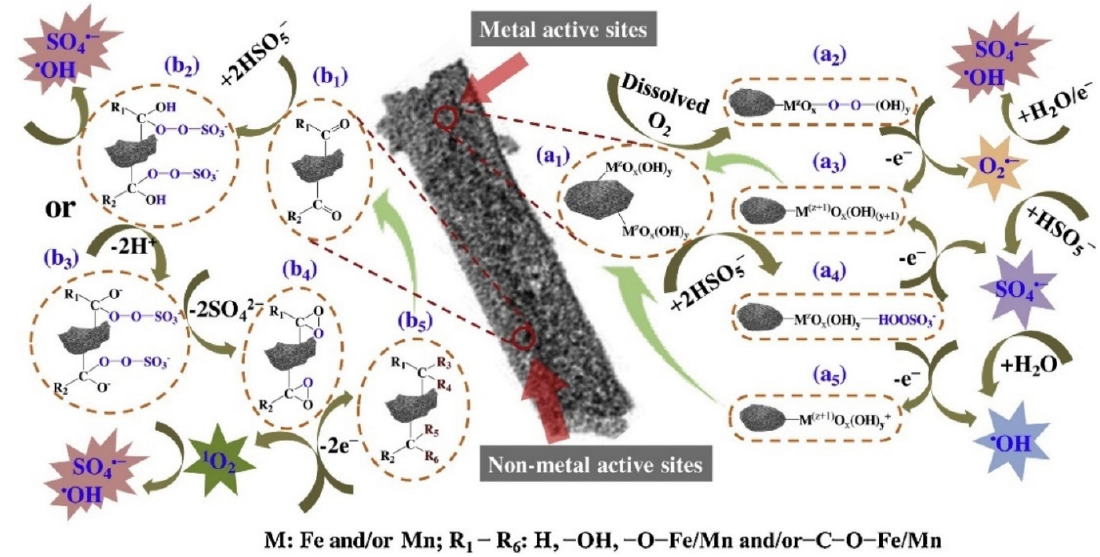
Figure 1. Proposed mechanism for peroxymonosulfate (PMS) activation by rod-shaped manganese iron oxycarbide and ROS formation. Reprinted from Fu et al. [38] with permission from Elsevier.